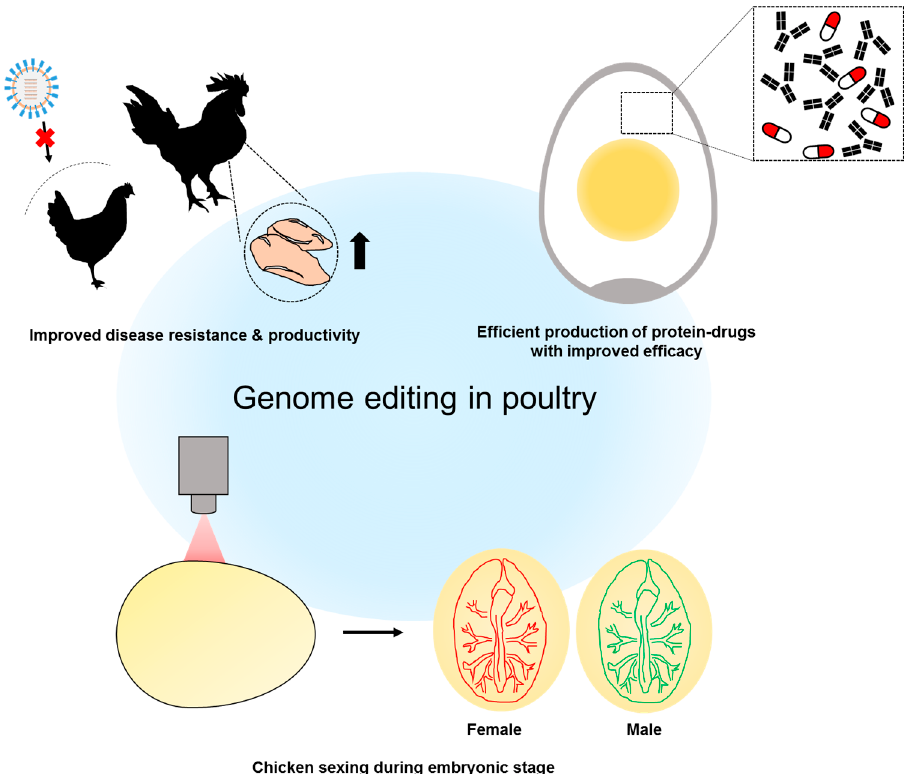
Figure 3. Schematic illustration for future application of genome-edited poultry to industries. Genome editing in poultry can improve disease resistance and meat productivity. By targeting egg white protein genes, genome edited poultry can economically produce protein drugs with improved biological efficacy. When the reported genes are targeted to the Z chromosome, the male embryo can be screened out before hatching by detecting fluorescence during incubation.